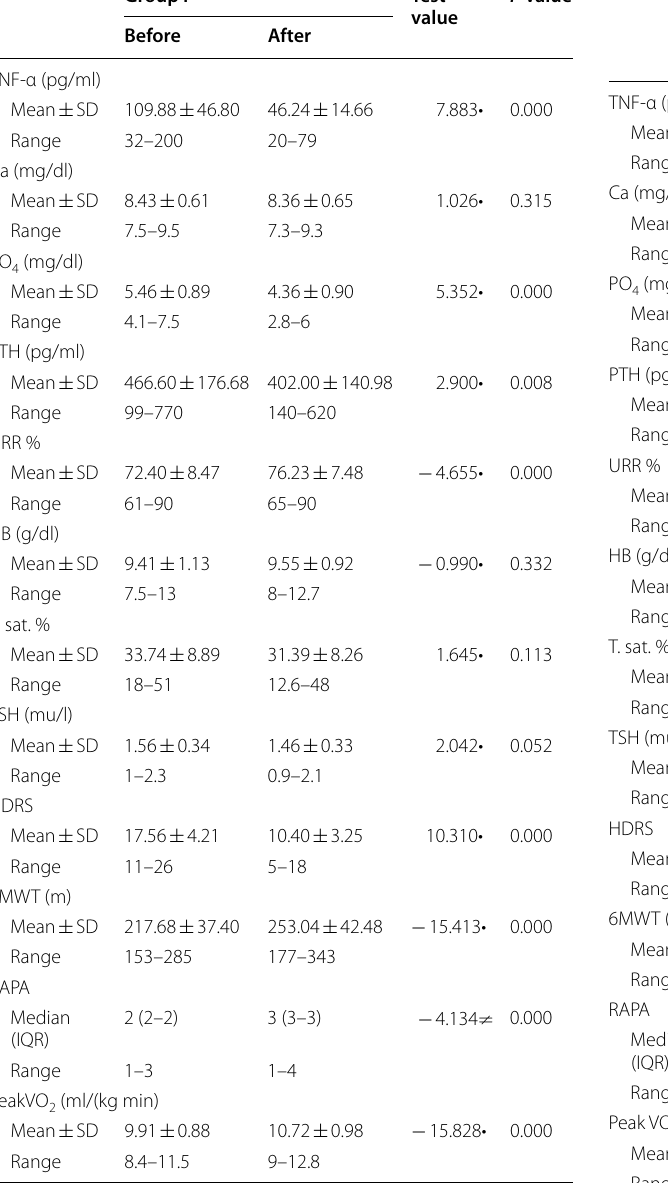
Table 2 Comparison between baseline values and values at end of the study in control group (group II) without doing